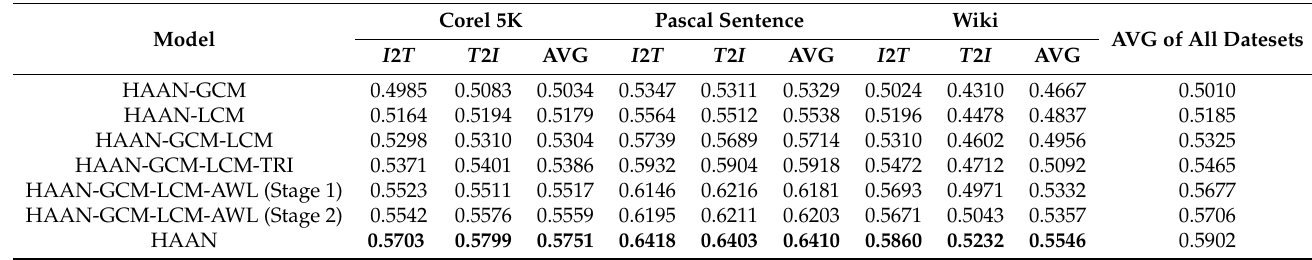
Table 6. Experimental results of ablation study on all datasets with mAP scores.